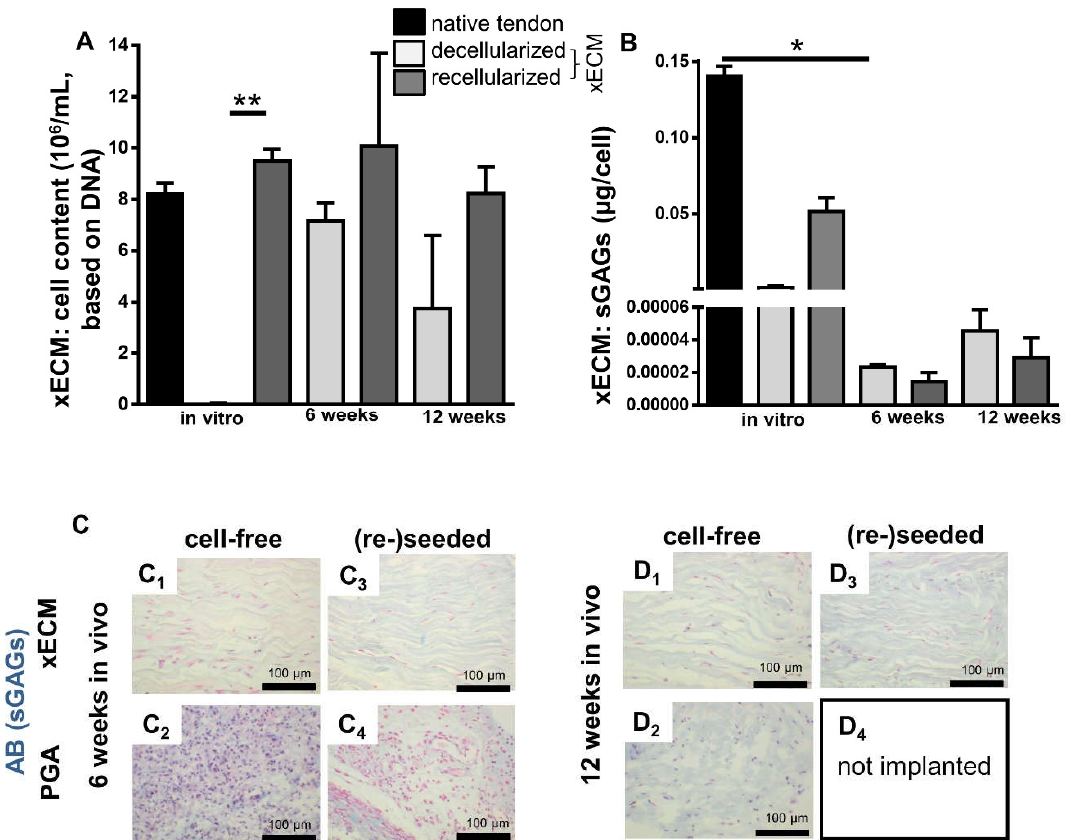
Figure 6. Cell and GAG content in native, decellularized and recellularized xECM in vitro and in vivo six and 12 weeks after implantation in the nude mice. ( A ) Cell content. Cell numbers were calculated by the assumption of 7.7 ng DNA per cell. ( B ) sGAG content assessed using the DMMB assay. ( C ) AB staining after six weeks ( A 1 – B 2 ) and 12 weeks ( C 1 – D 2 ) in vivo. Cell-free implanted samples ( A 1–2 , C 1–2 ) and samples, recellularized before implantation ( B 1–2 , D 1–2 ). Scale bars 100 μm. sGAGs: sulfated glycosaminoglycans., * p < 0.05, ** p < 0.01.